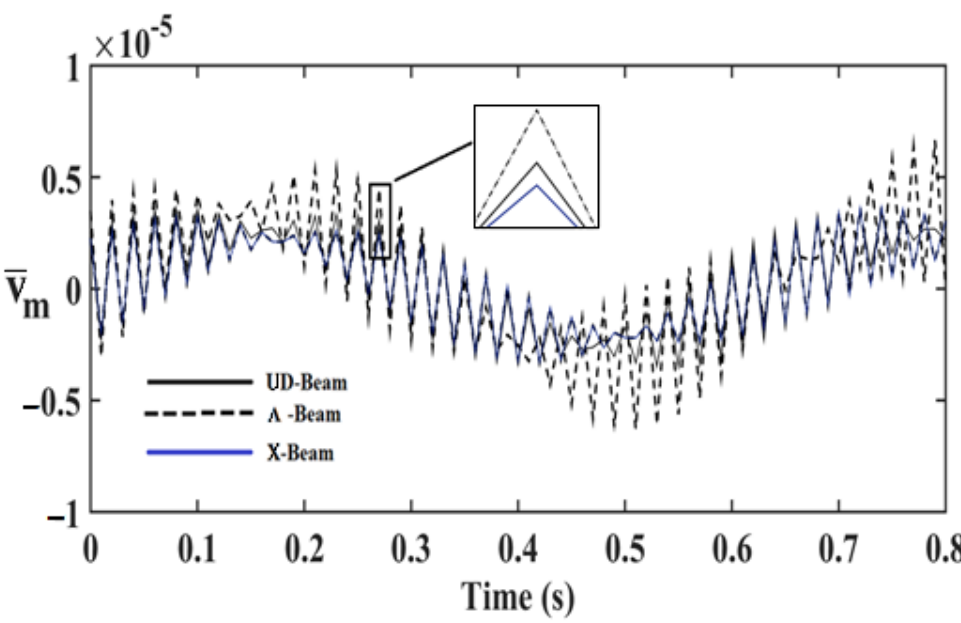
Figure 2. Time responses of the CNTRC beam with different reinforcement patterns for V CNT = 0.12.